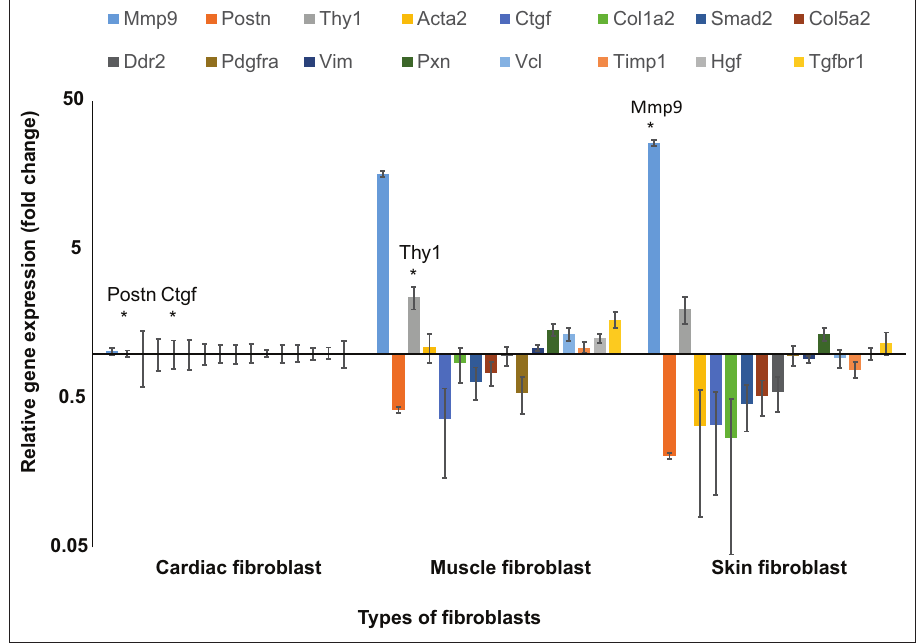
Figure-4: Relative gene expression of fibrotic genes compared among cardiac, muscle, and skin fibroblasts. The gene expressions of muscle and skin fibroblasts were calculated relative to cardiac fibroblasts (set to 1). *Represents the highest expression (p<0.01). The highest expression of matrix metallopeptidase 9 was found in skin fibroblasts. Periostin and connective tissue growth factor were highly expressed in cardiac fibroblasts. Thy-1 cell surface antigen was the most highly expressed in muscle fibroblasts. Cell culture was done in six replications while quantitative polymerase chain reaction was done in three replications.